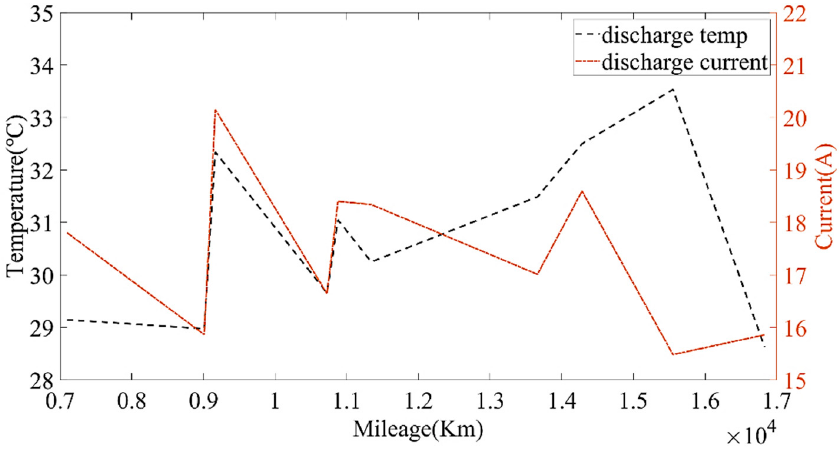
Figure 16. The relationship between the discharging temperature, discharging current and the mileage at the charging temperature of 35 °C.